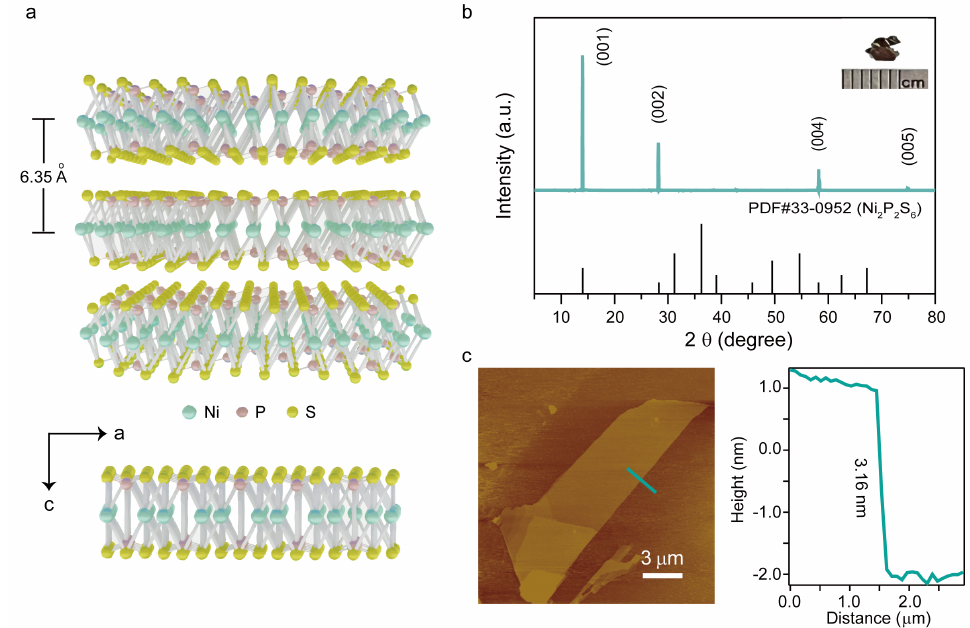
Figure 1. Structural characterizations of NiPS 3 . ( a ) Schematics of the crystal structure of NiPS 3 , and the blue, pink, and yellow spheres represent Ni, P, and S atoms, respectively. ( b ) The XRD pattern of the bulk NiPS 3 single-crystal along with the standard pattern. ( c ) Atomic force microscopic (AFM) topographic image of a typical few-layered NiPS 3 flakes, and the corresponding height profile measured across NiPS 3